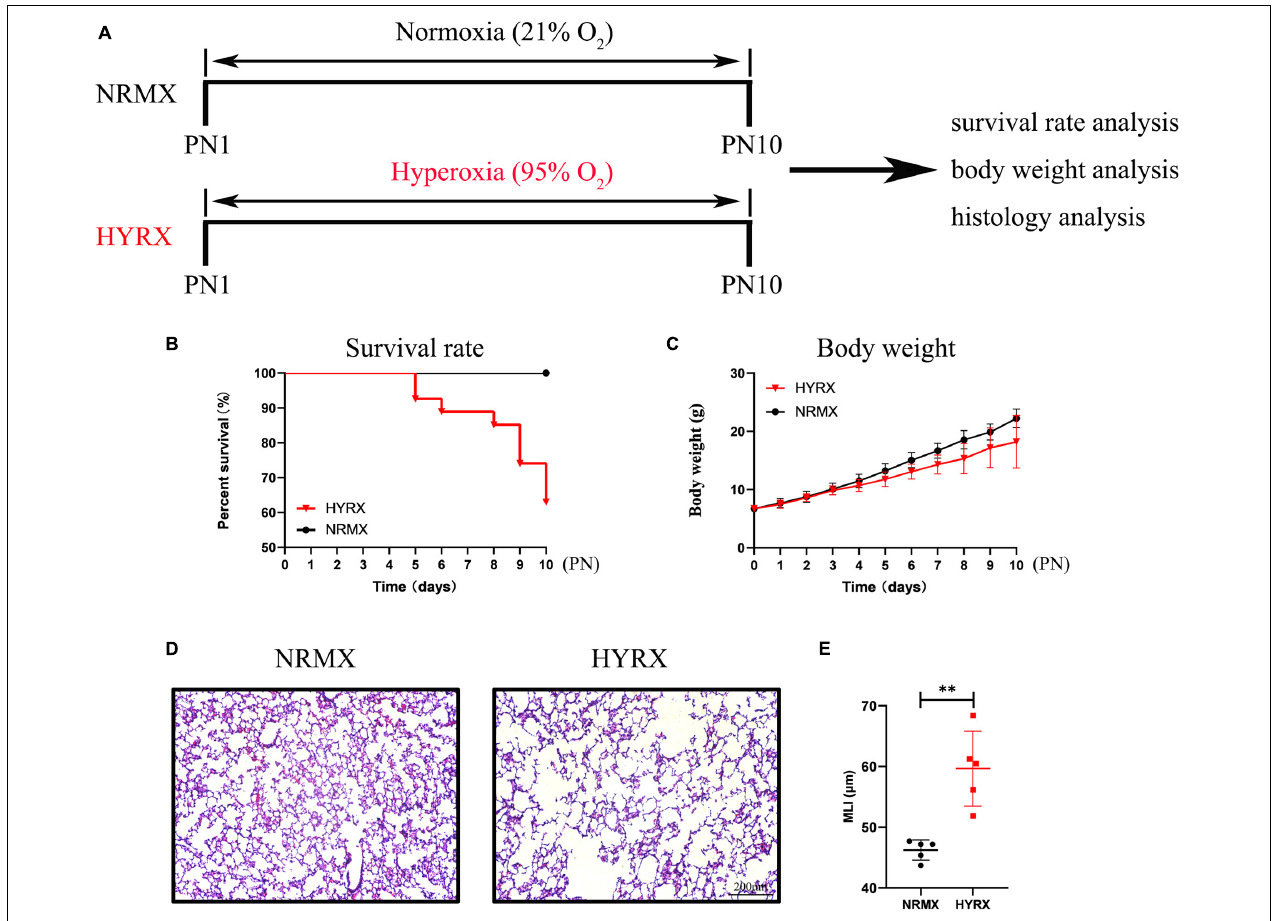
FIGURE 3 | Schematic of protocols used for rat BPD establishment, and survival rate, body weight, and lung histology analysis. (A) Newborn rat pups were exposed to hyperoxia (HYRX; 95% O 2 ) for 10 days during PN1 to PN10; rat pups that remained in normoxic (NRMX) conditions (21% O 2 ) were compared as control group. During PN1 to PN10, the survival rate (B) and body weight (C) in each point were recorded. Rat lung tissue were harvested at PN10 and lung sections were stained with H&E (D) . Scale bars, 200 µ m. Quantification of mean linear intercept (MLI) in each group represents a surrogate of average air space diameter (E) . Data are shown as mean ± SEM. n = 5–10. ∗∗ p <